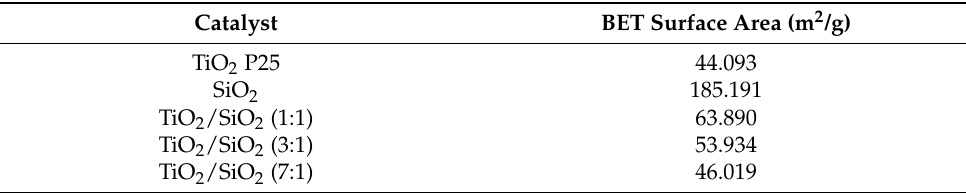
Table 5. The specific surface area of the photocatalyst.